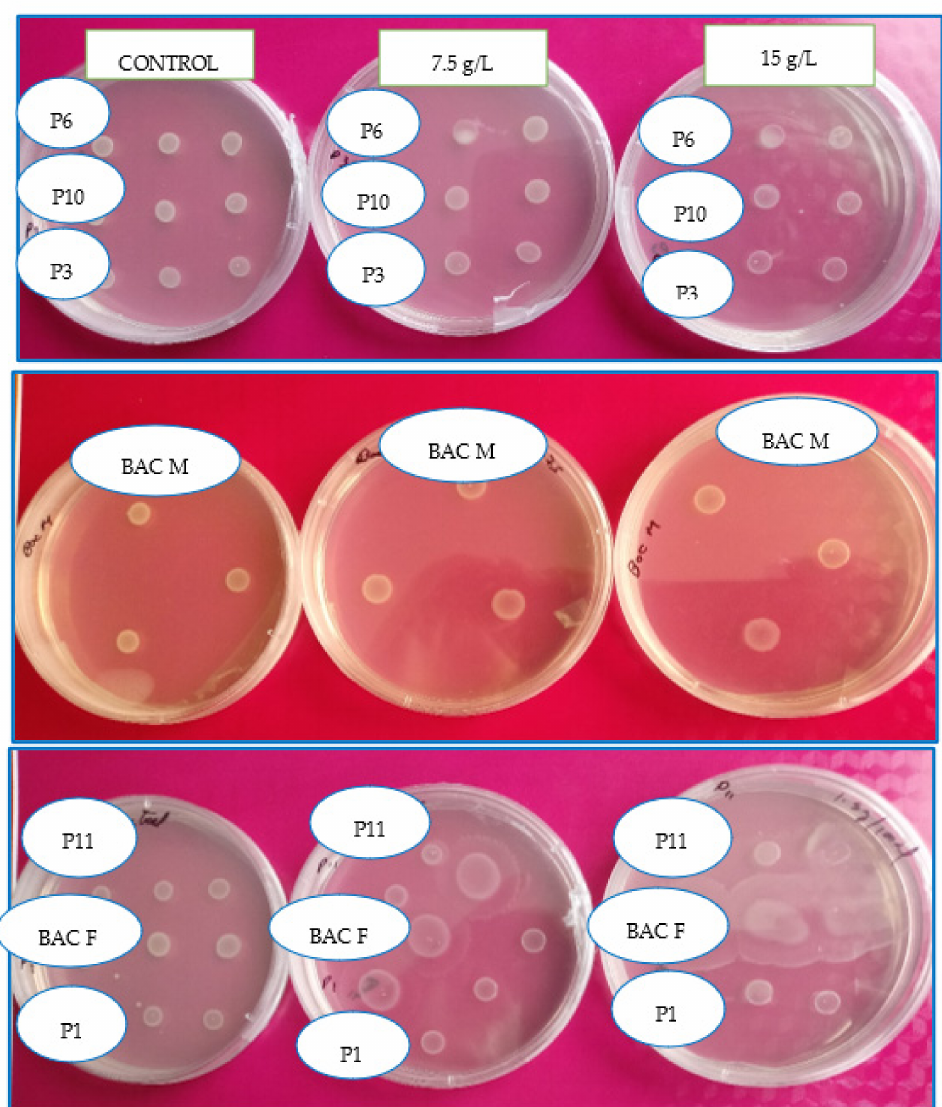
Figure 3. Growth of avocado rhizospheric bacteria in media with increasing concentrations of